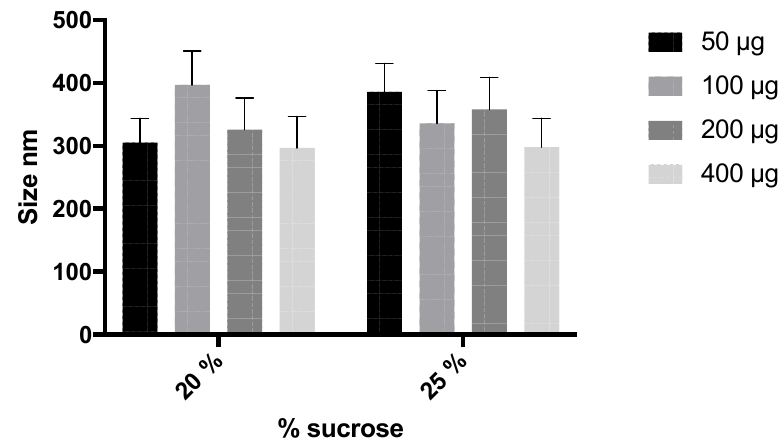
ff ect of the percentage of sucrose and enzyme loading on NLC Figure 1. Effect of the percentage of sucrose and enzyme loading on NLC size. Figure 1. E